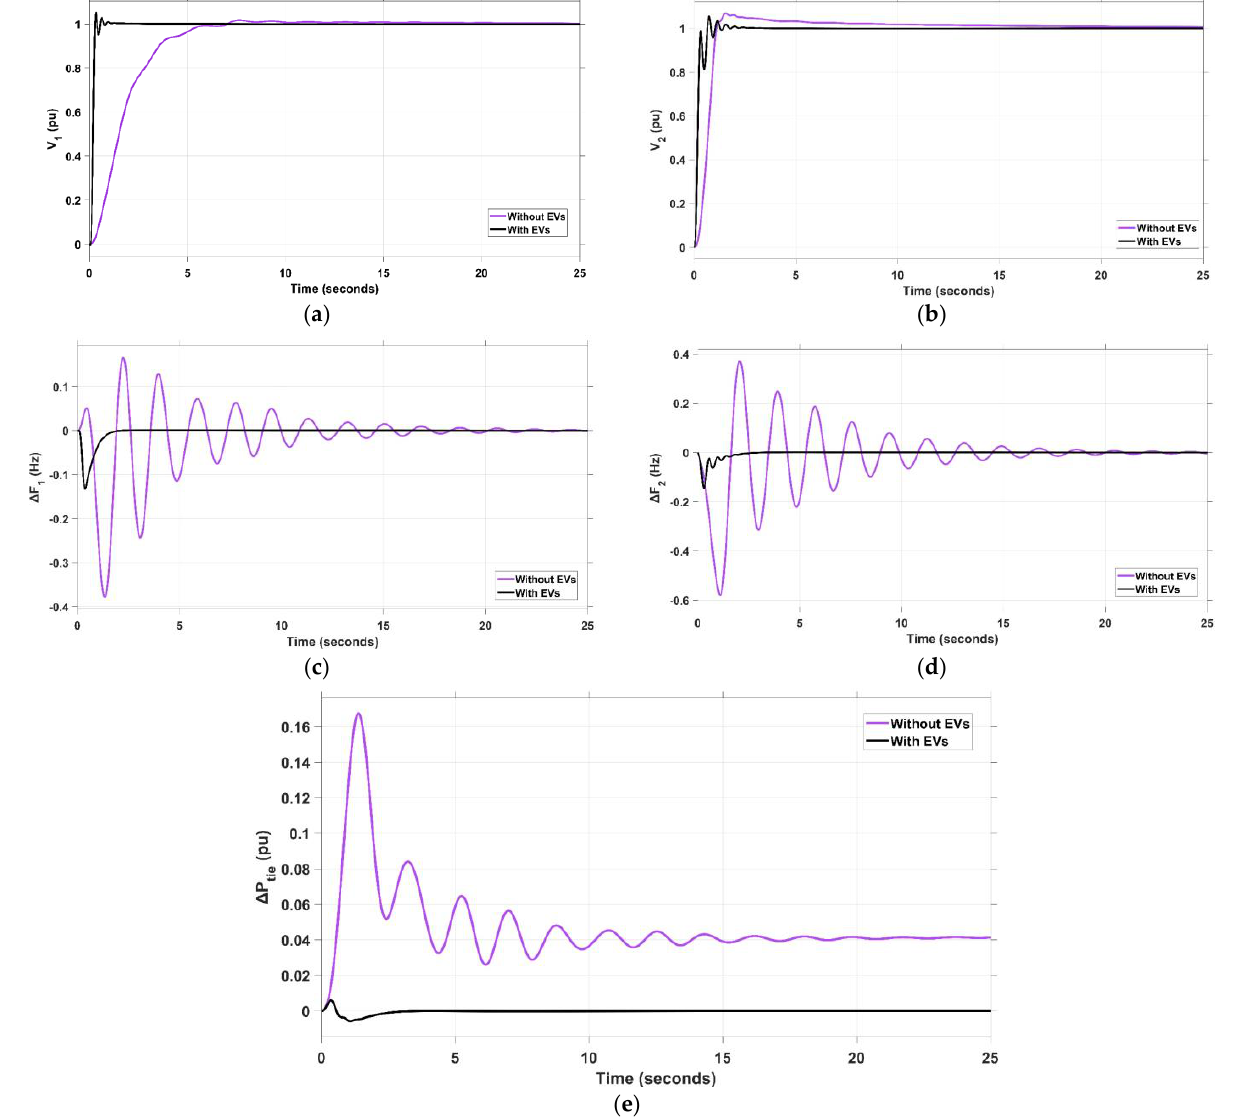
Figure 30. System dynamics for scenario 8 when using FOPI–PIDD 2 controller: ( a ) V 1 , ( b ) V 2 , ( c ) ΔF 1 , ( d ) ΔF 2 , and ( e ) ΔP tie . Table 11. Dynamic specifications of the investigated system represented as ITSE value using the proposed controller under scenario 8